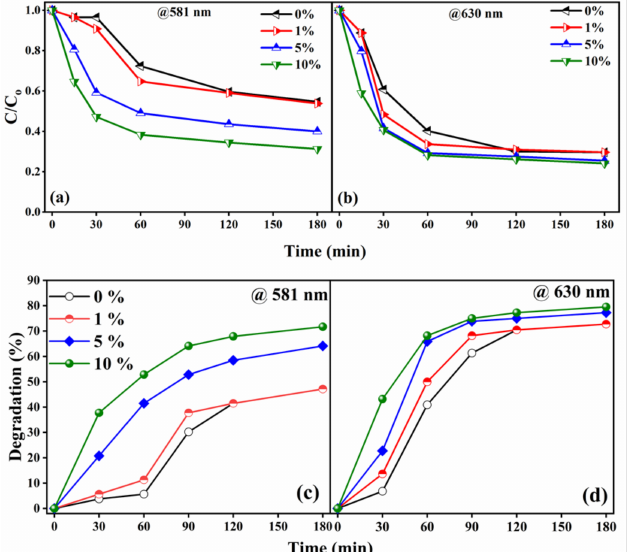
Figure 8. The C/Co vs. time plots for photocatalytic degradation of Rz ink for POP–BiF 3 (%) composites monitored at: ( a ) 581 nm and ( b ) 630 nm wavelength, and respective percentage of photocatalytic degradation for ( c ) 581 nm and ( d ) 630 nm